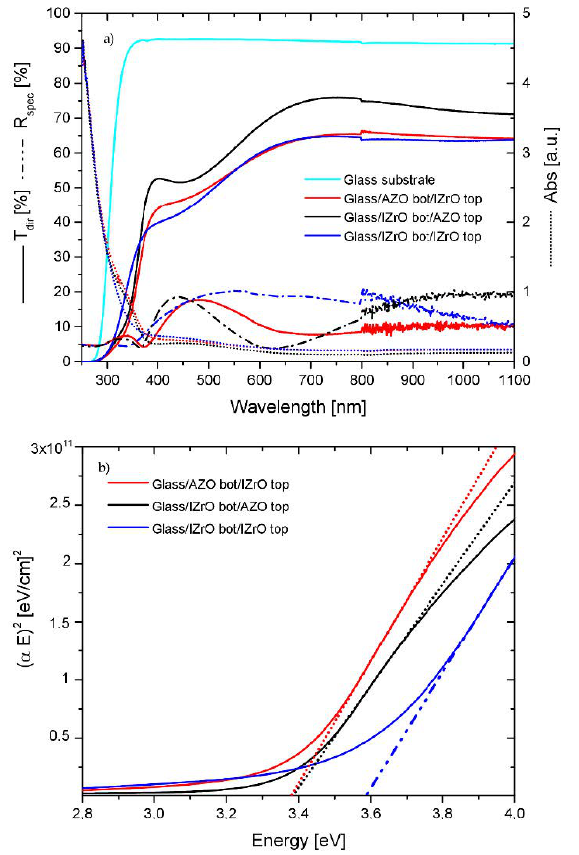
Figure 3. ( a ) Transmittance, reflectance, and absorbance curves of Glass/AZO bott /IZrO top , Glass/IZrO bott /AZO top , and Glass/IZrO bott /IZrO top double stack. The transmittance of the bare glass substrate is reported as a reference. ( b ) Tauc plots and calculated linear fit of the samples reported in ( a ).